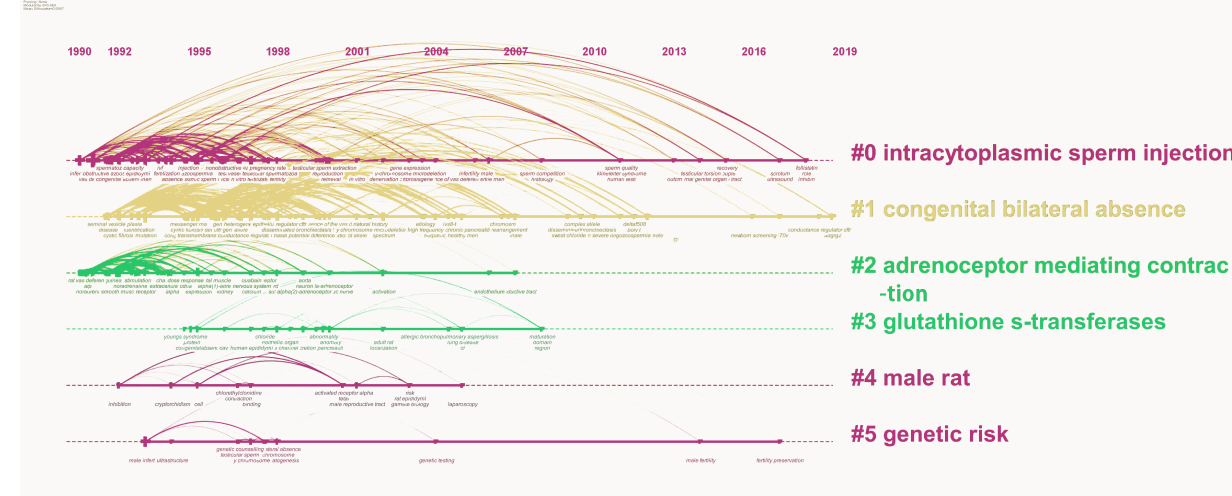
Fig. 8. Timeline view of the knowledge map in the AVD field. This view clearly presents the differences in the appearance time point and time span of six clusters.